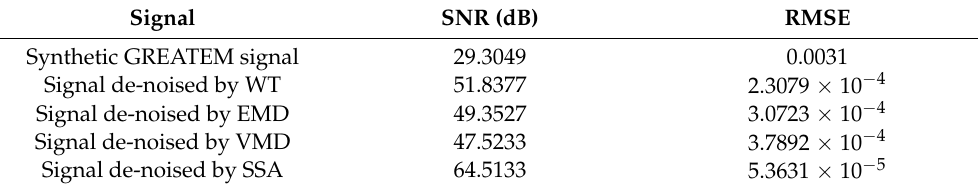
Figure 11. Comparison of measured noise de-noising results by different methods. ( a ) Overall view; ( b ) partially enlarged view. Table 2. Comparison of indexes of different methods to eliminate measured noise.